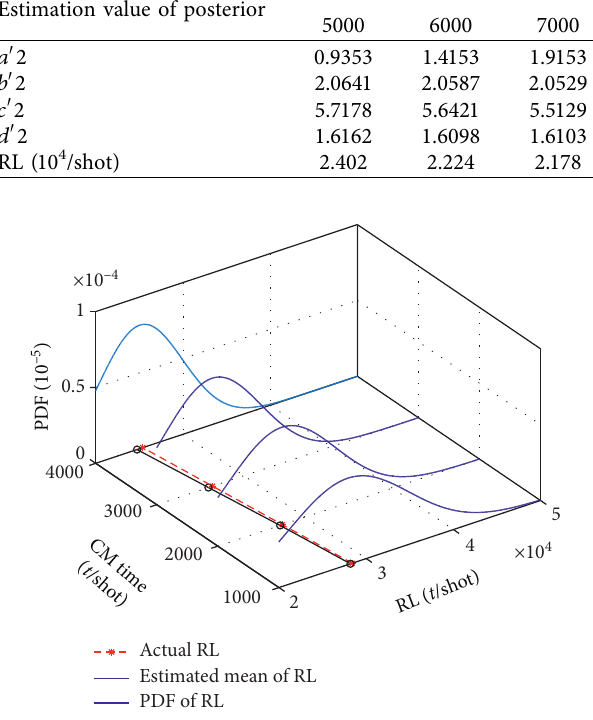
Figure 3: Probability density distribution of residual life (first stage).